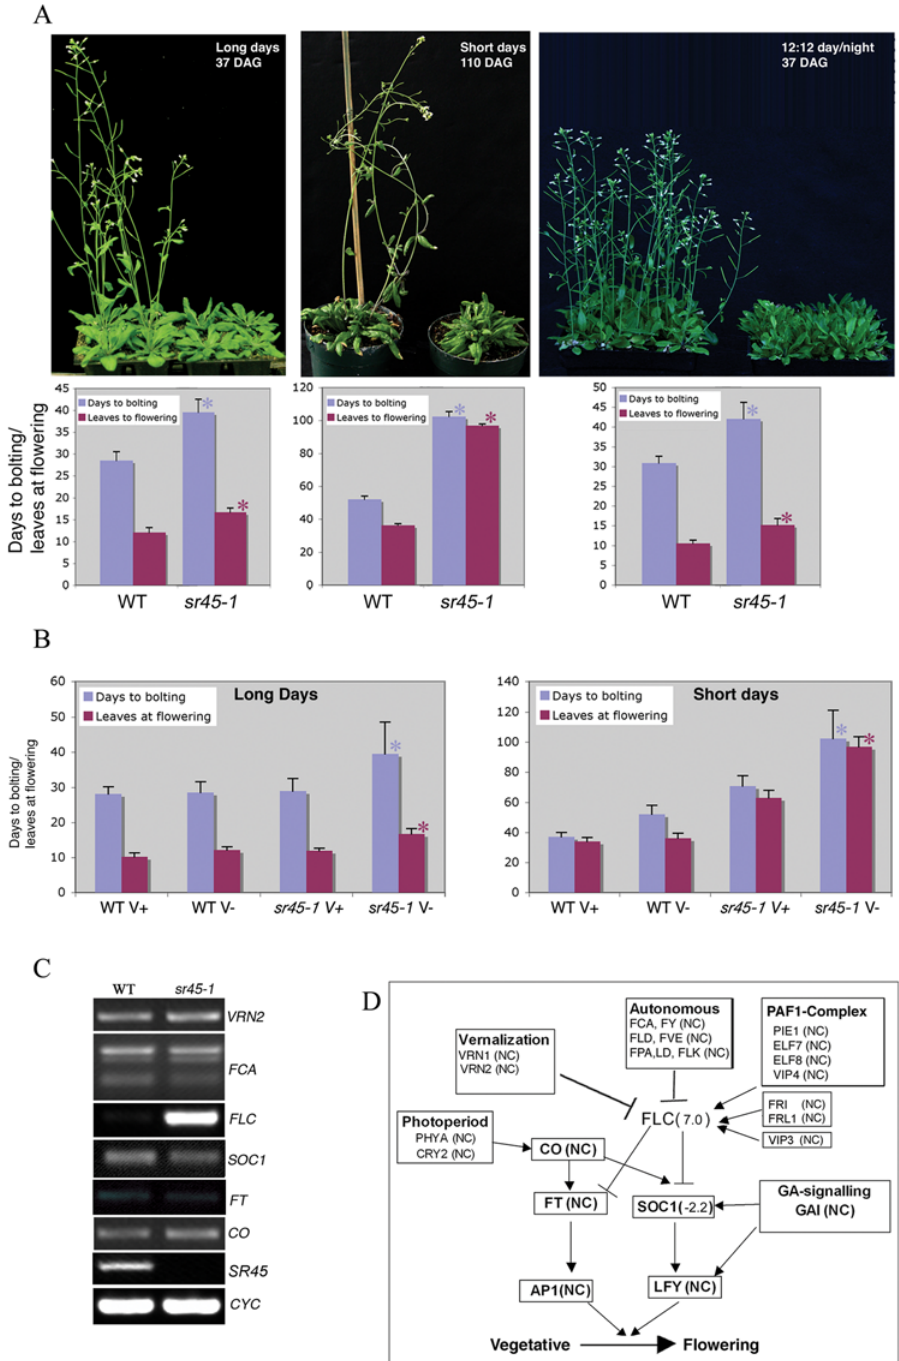
Figure 5. sr45-1 plants are late flowering. (A) Top panel: sr45-1 plants are considerably later flowering than WT under long-day (LD, 16 h:8 h light:dark), short-day (SD, 8 h:16 h light:dark) and 12 h:12 h light:dark conditions. Age of the plants at the time they were photographed is indicated on each panel. Bottom Panel: Quantification of flowering time. Transition to reproductive stage was measured as days to bolting and number of rosette leaves at the appearance of 1 st flower. Each bar is the mean 6 SEM of 48 to 72 plants. Significant differences ( p , 0.05) between WT and sr45-1 plants are indicated by ‘*’. Each experiment was repeated three times. (B) Effect of vernalization on flowering of sr45-1 plants. sr45-1 and WT seeds were stratified at 4 u C for 2 days or vernalized for 40 days at 4 u C and grown under LD (16 h photoperiod) or SD (8 h photoperiod) conditions in soil. Flowering time was measured as described in experimental procedures. V + and V-indicate vernalized and unvernalized plants, respectively. Significant differences ( p , 0.05) between vernalized and unvernalized plants are indicated by ‘*’. Each experiment was repeated three times. (C) Expression analyses of flowering related genes in sr45-1 and WT plants. Expression of representative genes in various flowering pathways was analyzed by RT- PCR. VRN2 belongs to the vernalization pathway, FCA to the autonomous pathway; FLC integrates signals from these two pathways. CO belongs to the photoperiod pathway. SOC1 and FT function downstream of FLC . Each RT-PCR was repeated at least three times. (D) Expression levels of various genes in the flowering time pathways of Arabidopsis. Model is adapted from [24,70]. Value in parentheses next to a gene indicates induction or repression of that gene in sr45-1 . NC, No change.